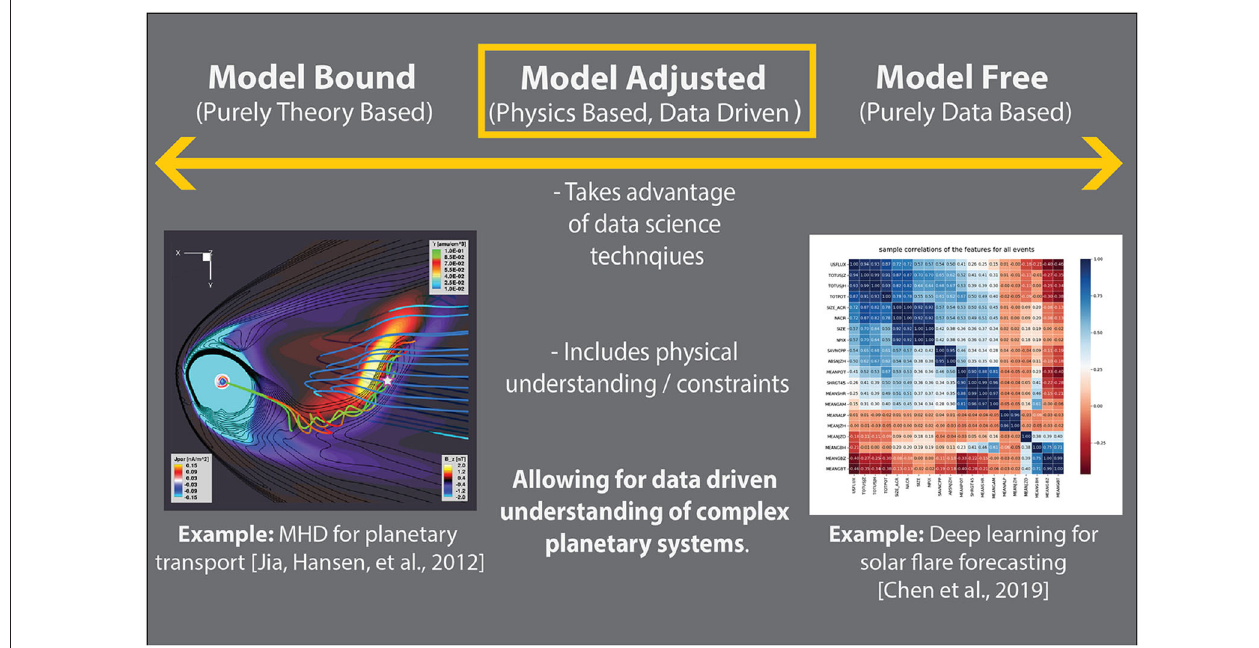
FIGURE 1 | Framework for incorporating physical understanding in machine learning. This figure diagrams a continuum moving from purely theory bound, toward model free. The figure in model bound is from Jia et al. (2012), a magnetohydrodynamics simulation of Saturn’s magnetosphere. The figure in model free is from Chen et al. (2019) , deep learning feature correlations for solar flare precursor identification. This figure contains subfigures from American Geophysical Union (AGU) journals. AGU does not request permission in use for republication in academic works but we do point readers toward the associated AGU works for citation and figures in Jia et al. (2012) and Chen et al.